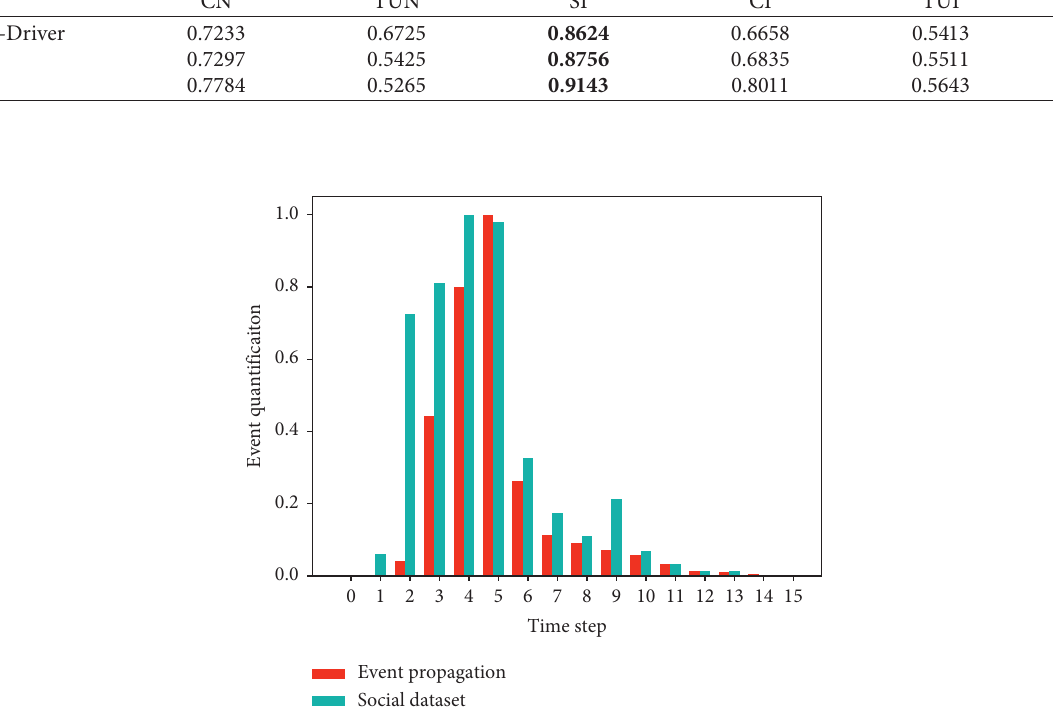
Figure 8: The quantitative relationship between the event popularity evolution and the social intensity of the event Chengdu-Driver. An apparent positive correlation between popularity and social intensity can be